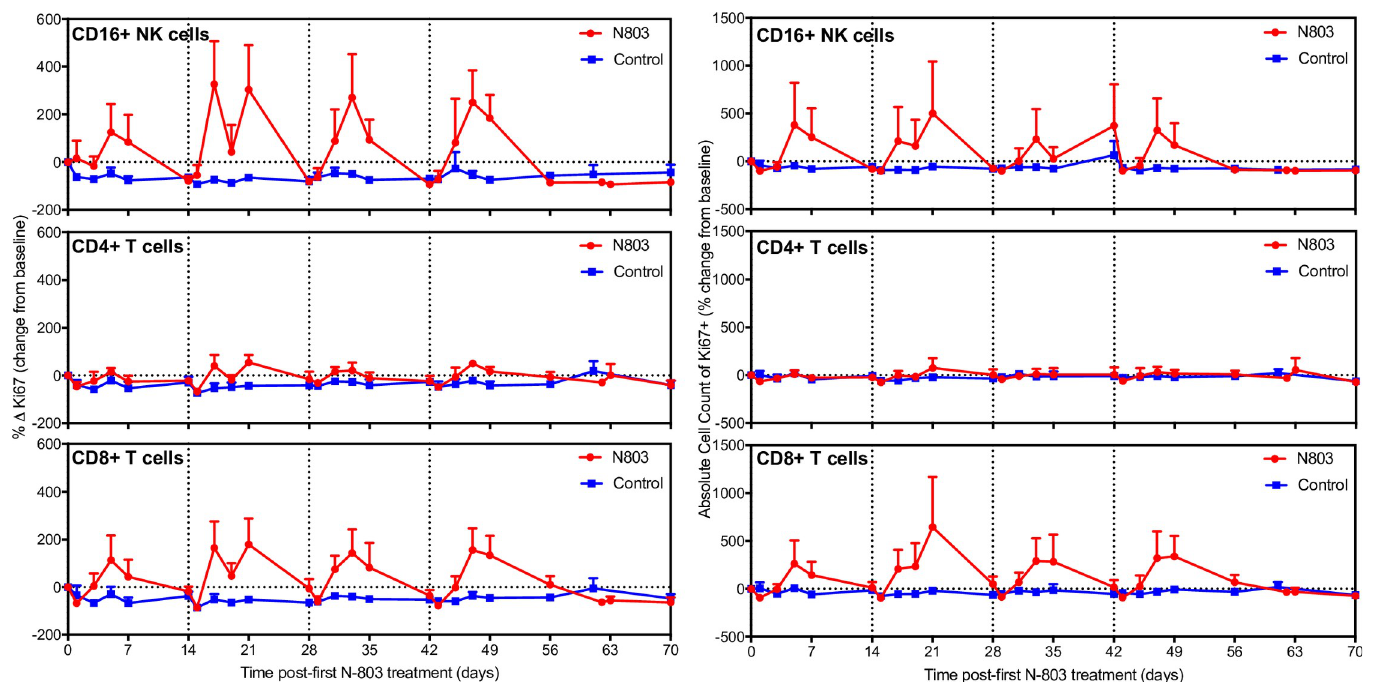
Fig 2. Whole blood analysis during in vivo administration of N-803. N-803 was subcutaneously administered every other week as indicated by the vertical dashed lines. Blood was collected at time 0 before the N-803 injection and at days 1, 3, 5, 7 after each injection of N-803. Induction of proliferation marker Ki67 on CD16+ NK cells, CD4+ and CD8+ T cells as percent of lymphocyte subset on the left, absolute cell counts on the right, both shown as a percent change from baseline. Absolute counts were calculated based on the percentage of the particular cell subset and the WBC count. Data shown are means ( ± SEM) of combined data from all animals within the designated